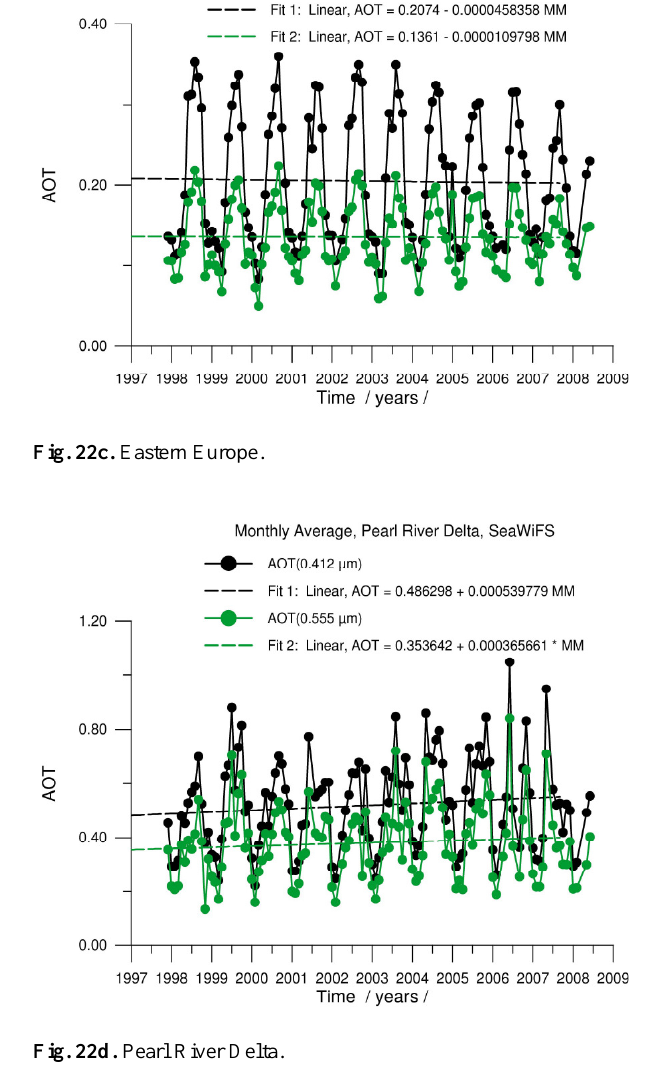
Fig. 22d. Pearl River